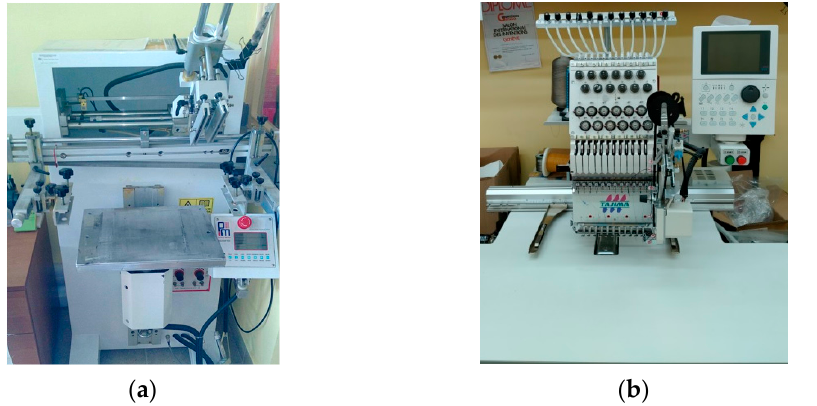
Figure 1. ( a ) The MS-300 machine used in the screen-printing method, ( b ) “Tajima” embroidery machine, model: “TMEX-C1201”.